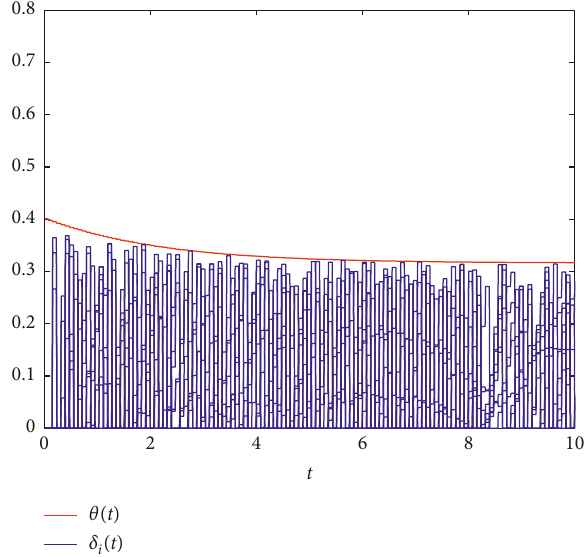
Figure 12: Evolution of measurement error and threshold with θ